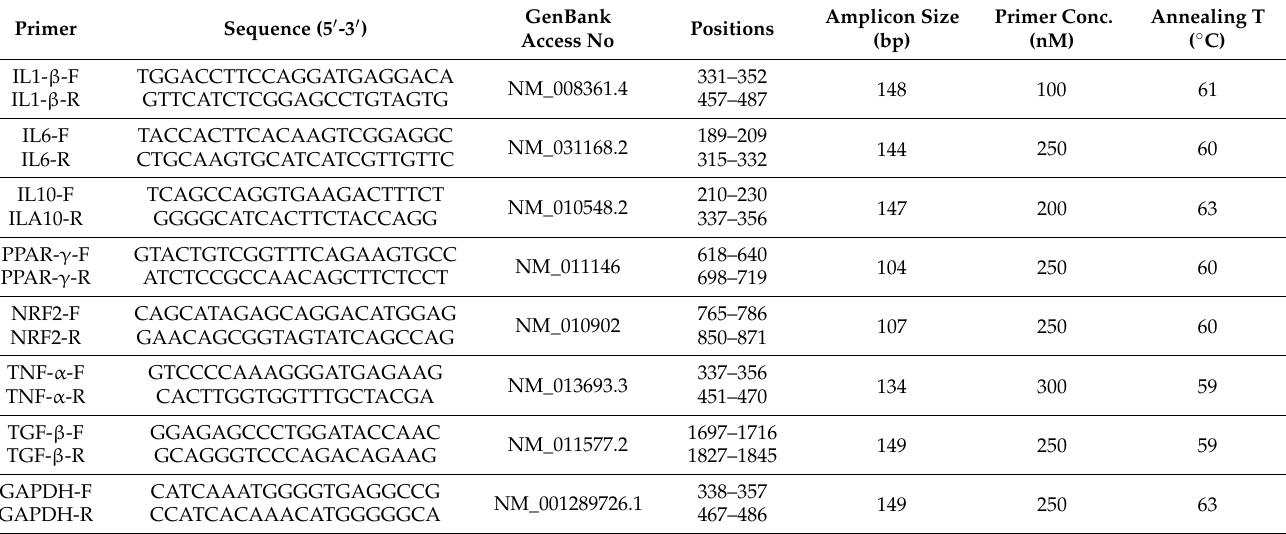
Table 1. Primers used for gene expression